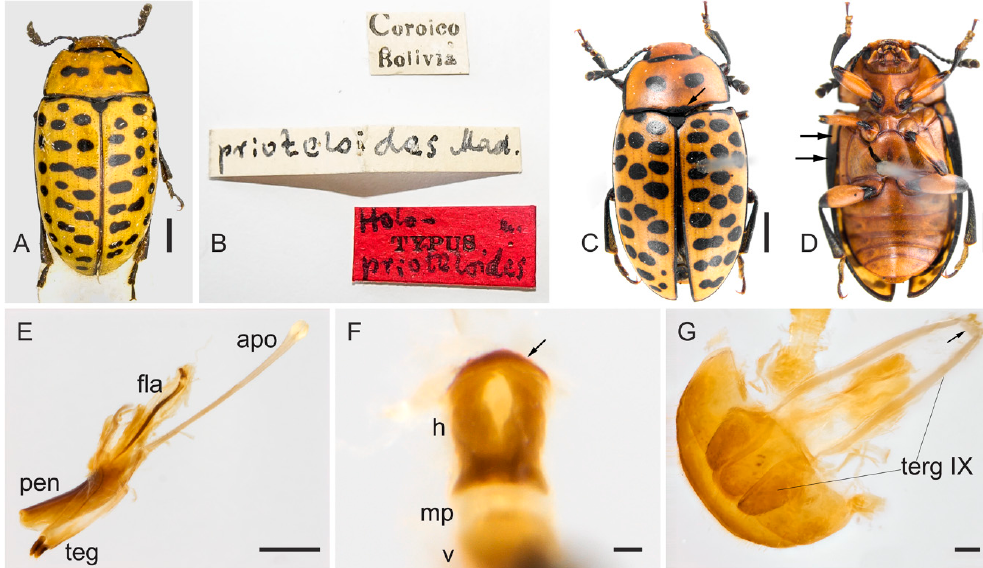
Figure 11. ( A – D ) Specimens of Mycotretus prioteloides Mader, 1942: ( A – B ) holotype (Coroico, Bolivia): ( A ) dorsal view, black arrow showing the transverse black mark at the anterior pronotal edge. ( B ) Labels. ( C – G ) Male (Torentoy Canyon, Base Machu Picchu, Peru): ( C – D ) dorsal and ventral view, respectively, ( E – G ) genitalia. ( C ) Arrow showing the black mark at the posterior pronotal edge; ( D ) arrows showing the elytral epipleuron partially black and yellowish; ( E ) lateral view of the aedeagus, showing apophyses (apo), flagellum (fla), penis (pen) and tegmen (teg); ( F ) dorsal view of the flagellum, showing head (h), anterior tip of virga (v) and the membranous portion (mp), arrow showing conspicuously convex anterior edge; ( G ) abdominal segments VIII–X: laterotergite IX (terg IX), arrow showing the sclerite at the anteroventral edge of segment IX. Scale bars: A , C – D = 1 mm; E = 0.5 mm; F – G = 0.1 mm.